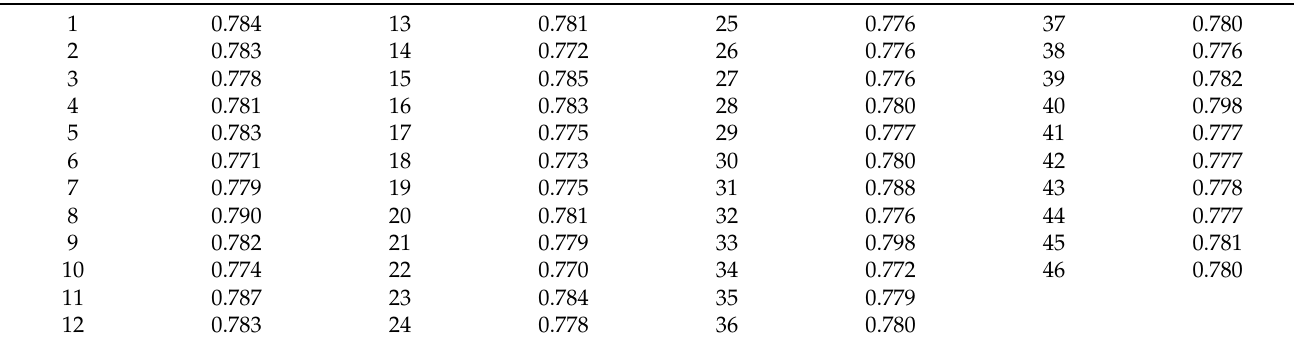
Table 2. KR20 coefficient if item deleted.